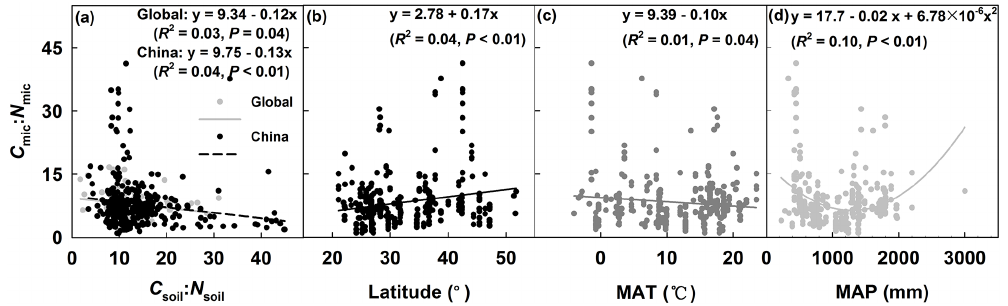
Figure 6. Relationships between C mic :N mic and C soil :N soil ratios (China: from this study vs. Globe: from Cleveland & Liptzin, 2007; a ), latitude (b) , MAT (c) , and MAP (d) , respectively. C soil , N soil , C mic , N mic , MAT, and MAP stand for soil organic carbon, soil total nitrogen, microbial biomass carbon, microbial biomass nitrogen, mean annual temperature, and mean annual precipitation, respectively. The regression models are given.